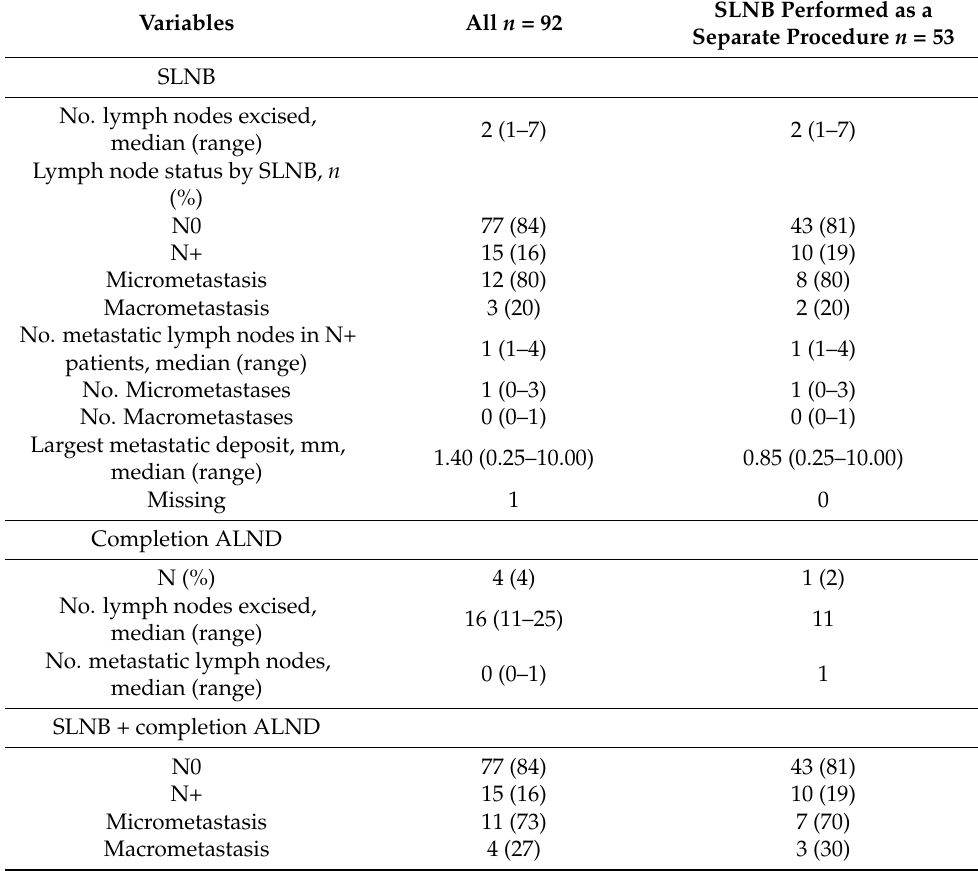
Table 2. Axillary lymph node status and nodal